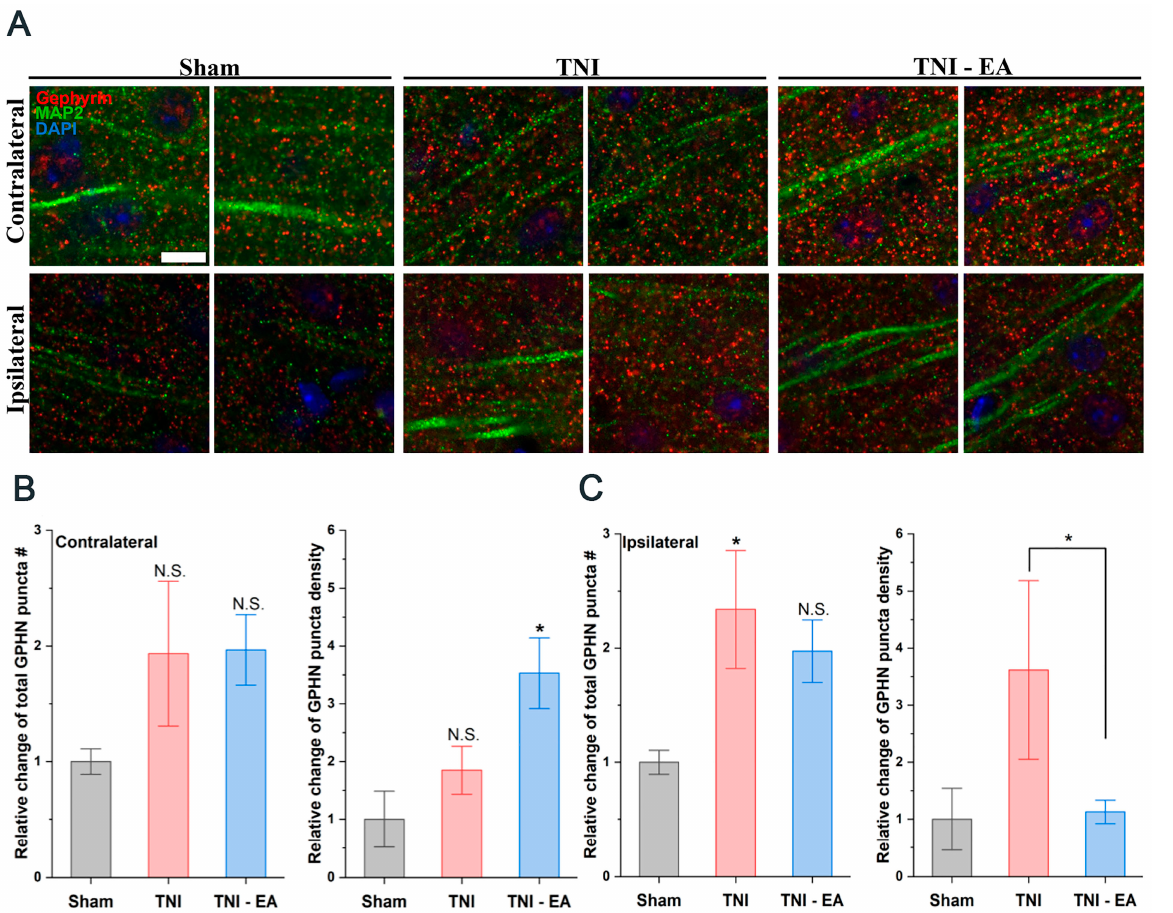
Figure 5. ( A ) Contralateral ( top panel ) and ipsilateral ( bottom panel ) of S1 cortex stained for gephyrin and MAP2 using samples from sham ( left ), TNI ( middle ), and EA- treated TNI ( right ) mice. Scale bar = 10 µ m. Relative change in gephyrin density per area (pixel 2 ) ( left ) and per neurite length (pixel) ( right ) from contralateral ( B ) and ipsilateral ( C ) side. N = 4. N.S.: no significance compared with Sham group. *: p < 0.05 compared with Sham group or as indicated. # :